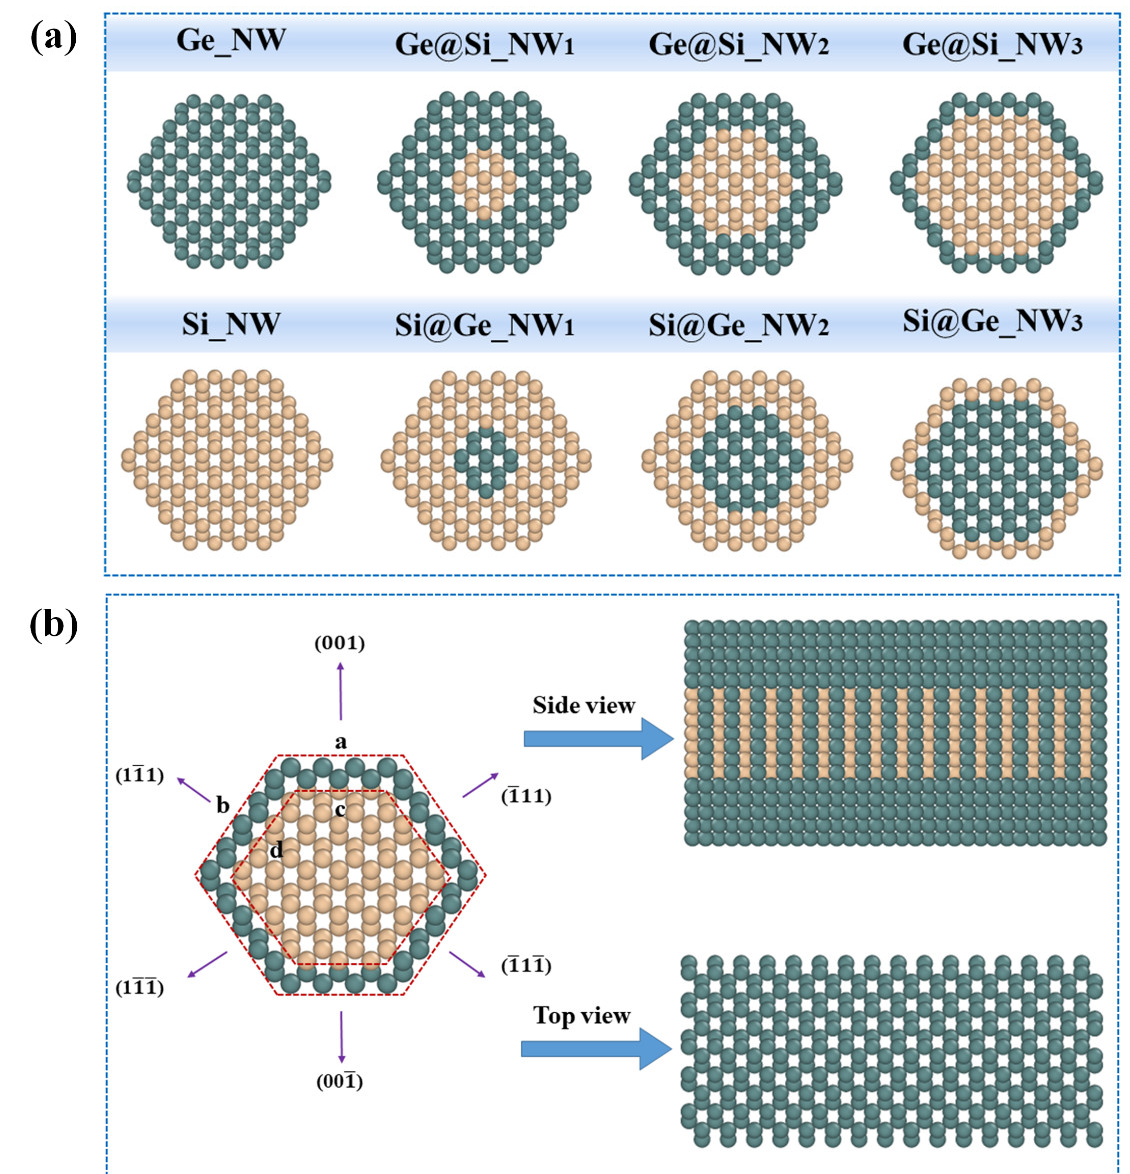
Figure 1. ( a ) Two-dimensional projections of the atomic structures and initial cross-sections for Ge@Si and Si@Ge nanowires from a [110]-oriented view; ( b ) a typical example of a two-dimensional projection of the atomic structure of all views for Ge@Si_NW 3 . Table 2. The structural parameters of Ge@Si and Si@Ge nanowires with different core–shell ratios.